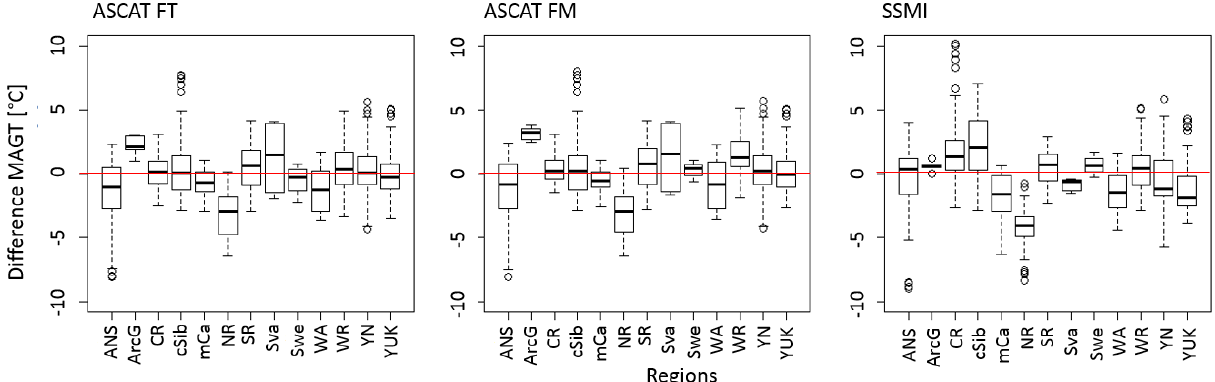
Figure 9. Difference between in situ MAGT c (coldest sensor) and modelled MAGT c by region (see Fig. 1 for abbreviations and map) for all years. Only stations which overlap with records from all data sets are considered. FT – days identified as frozen without melting snow are used; FM – days with melting snow are considered to be frozen ground in ASCAT.